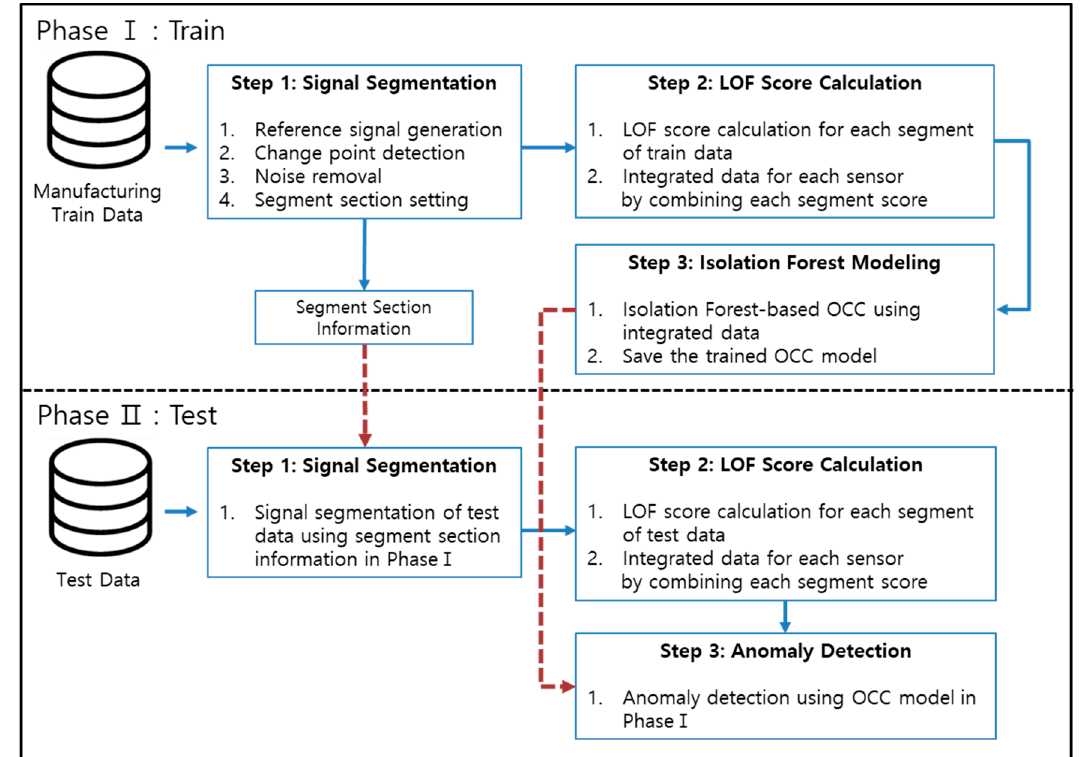
Figure 3. Schematic diagram of the proposed method.